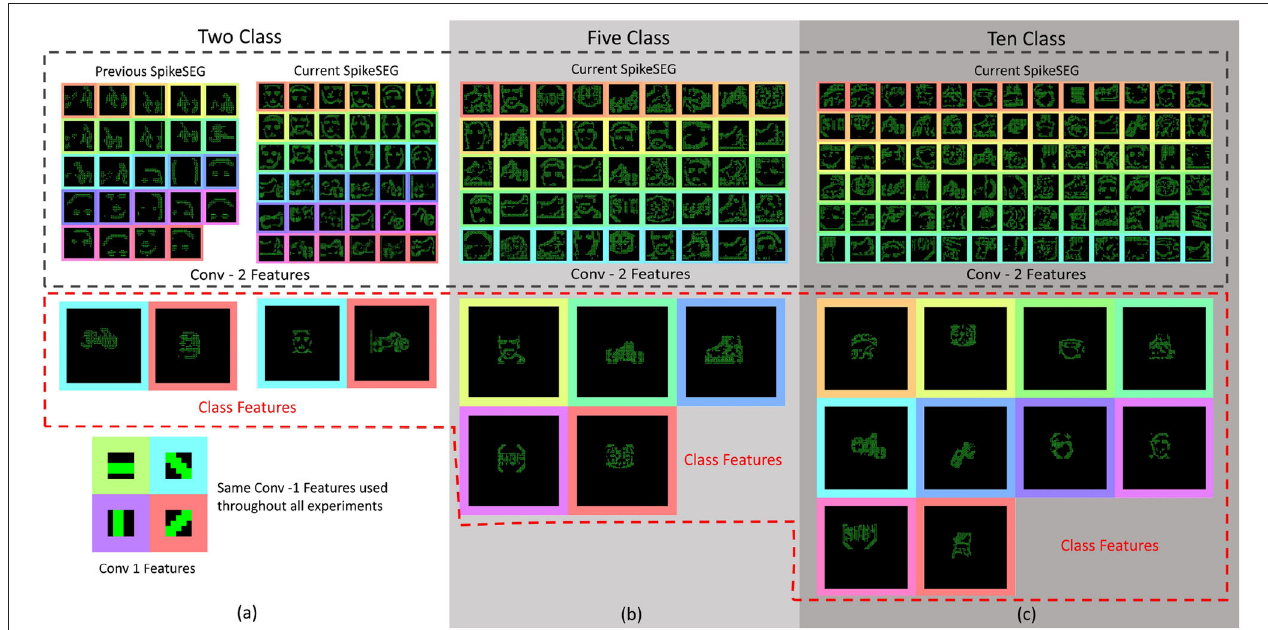
FIGURE 14 | (a) Features map representations of the convolution layers, with coloring to match the latent space representation from the two class experiment, showing prior and current results of the Conv-2 features and Class features. The Figure also shows a selection of features from both the Five Class (b) and Ten Class (c) experiments. Top half showing the Conv-2 features and the bottom showing the Class Features. (a) Classes shown in Class Features are Motorbike-Face then Face-Motorbike for the previous and current results. (b) Classes shown in Class Features order are: Face, Motorbike, In-line Skate, Stop Sign, and Watch. (c) Classes shown in Class Features order are: Stegosaurus, Watch, Cup, In-line Skate, Motorbike, Revolver, Camera, Face, Stop Sign, and Windsor